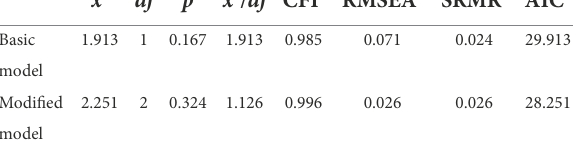
TABLE 2 Model comparison.